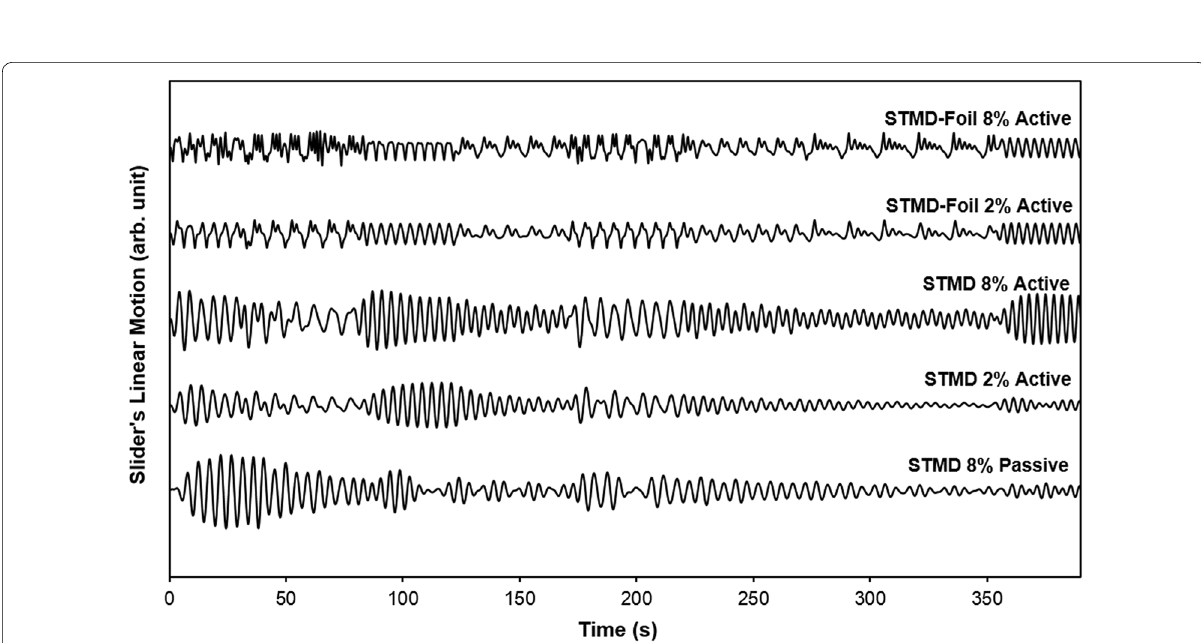
Fig. 17 Time domain displacement of the slider at different control strategies The linear motion of the slider along the frame which causes the suppresion of the buoy’s pitch deviation at different control strategies is